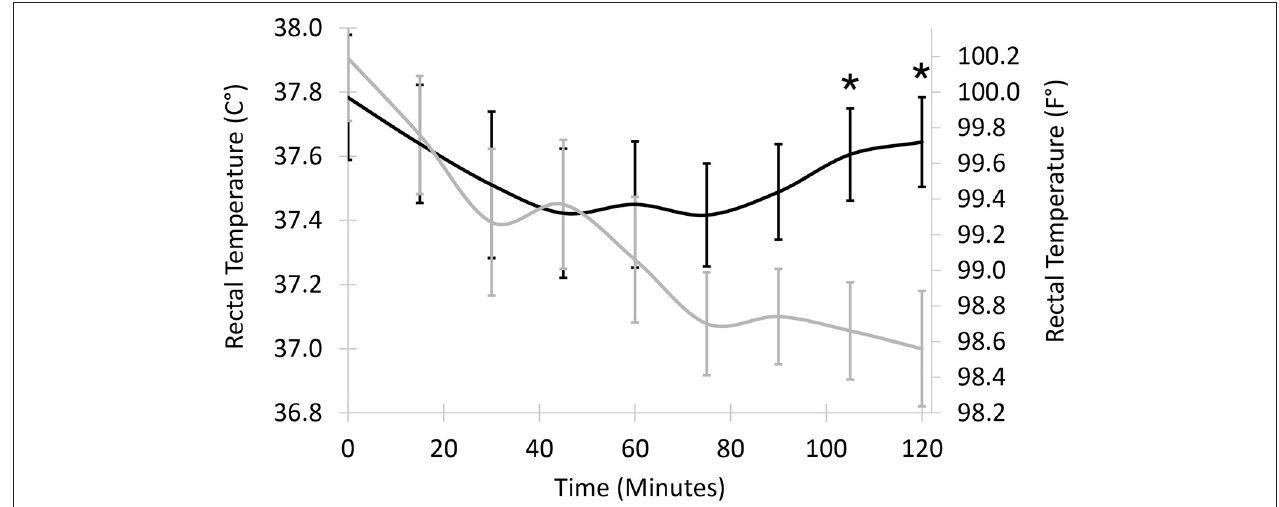
FIGURE 1 | Least squared mean core temperature in 20 dogs undergoing stifle joint surgery treated with a soft padded bandage ( n = 10, black line) or cold compression therapy ( n = 10, gray line). Vertical bars represent standard errors to the means. Temperatures differ statistically between least squared means 105 and 120min after surgery (asterisks, P = 0.018 and 0.013,